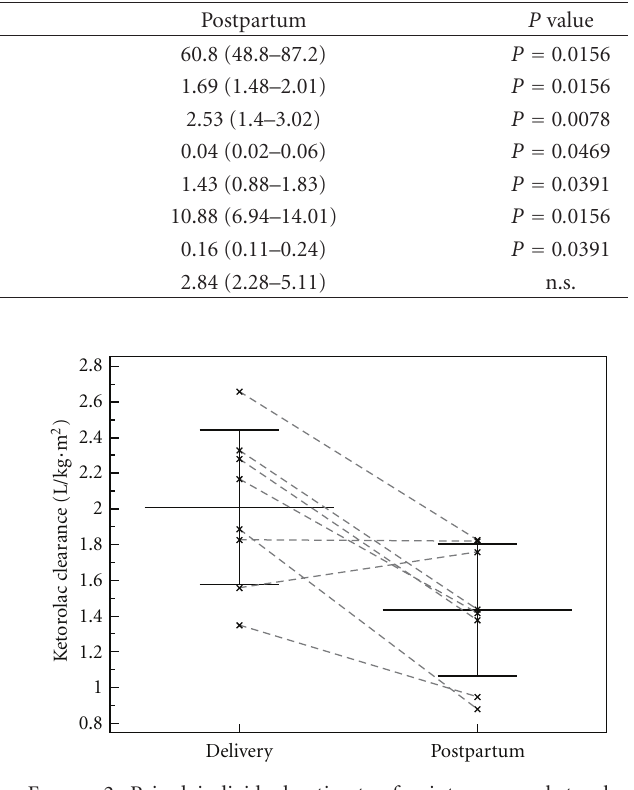
Figure 2: Paired individual estimates for intravenous ketorolac clearance at delivery or in postpartum (L/h · m 2 ) and mean with standard deviation for both time